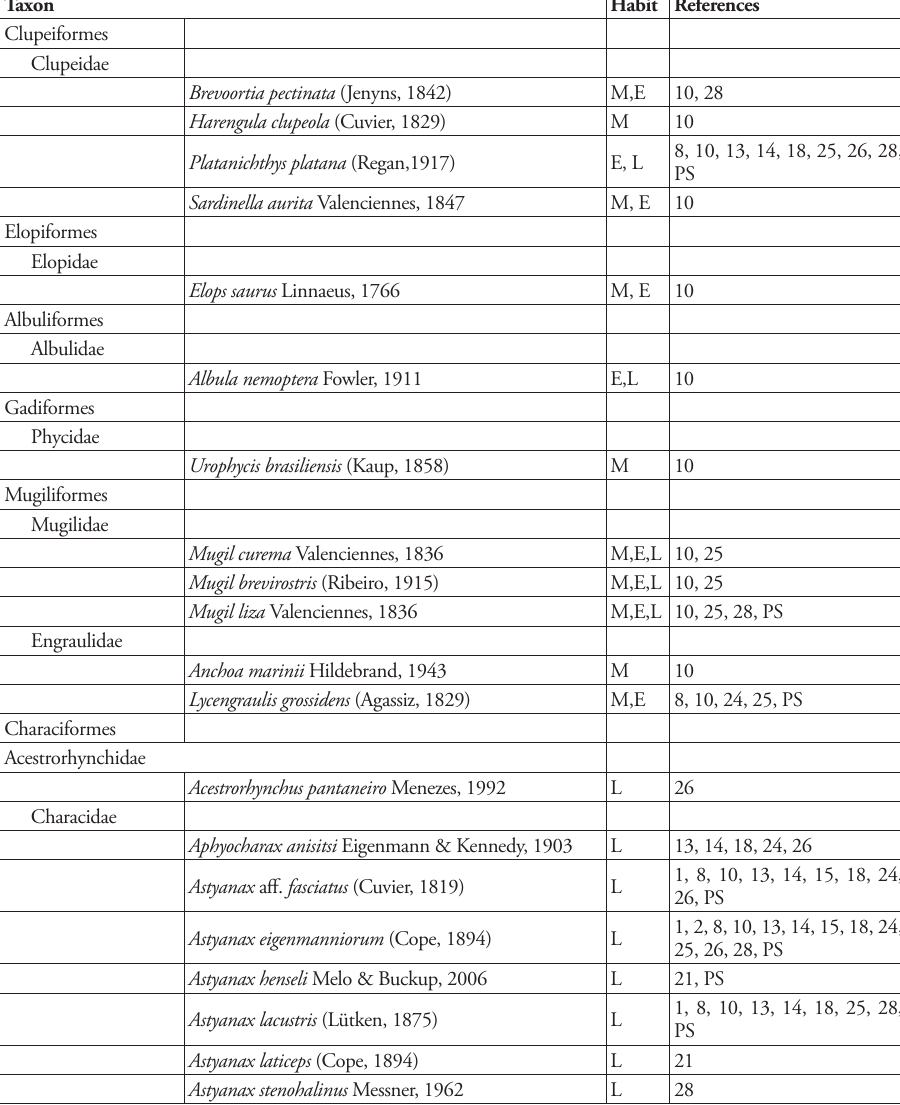
Table 1. Checklist of fish species recorded in limnic systems of Quaternary deposits in Rio Grande do Sul State. References: 1) Malabarba and Isaia (1992), 2) Tagliani (1994), 3) Buckup and Reis (1997), 4) Costa and Cheffe (2001), 5) Costa (2002), 6) Costa and Cheffe (2002), 7) Malabarba and Dyer (2002), 8) Schifino et al. (2004), 9) Costa and Cheffe (2005), 10) Loebmann and Vieira (2005), 11) Lucinda (2005), 12) (Costa (2006), 13) Garcia et al. (2006), 14) Becker et al. (2007), 15) Quintela et al. (2007), 16) Giora et al. (2008), 17) Lucinda (2008), 18) Artioli et al. (2009), 19) Costa and Lanés (2009), 20) Claudino et al. (2010), 21) Volcan et al. (2010), 22) Correa et al. (2011), 23) Carvalho and Reis (2011), 24) Volcan et al. (2012), 25) Bastos et al. (2013), 26) Malabarba et al. (2013), 27) Lanés et al. (2015), 28) Burns et al. (2015), 29) Giora and Malabarba (2016); PS = present study, M (marine), E (estuarine), L